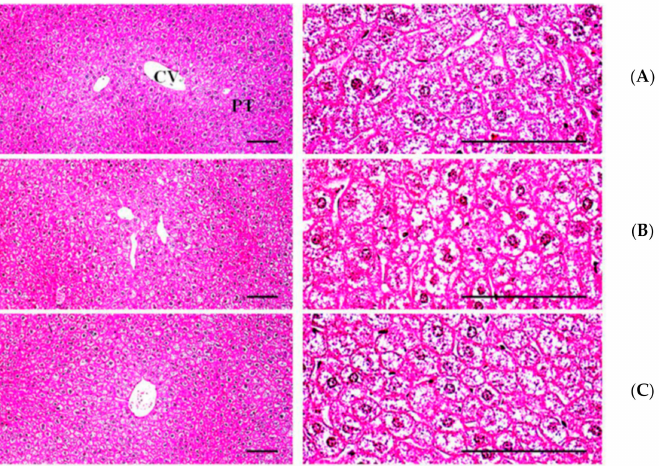
Figure A1. Representative histopathological profiles of liver tissues: ( A ) normal diet control ( n = 7);